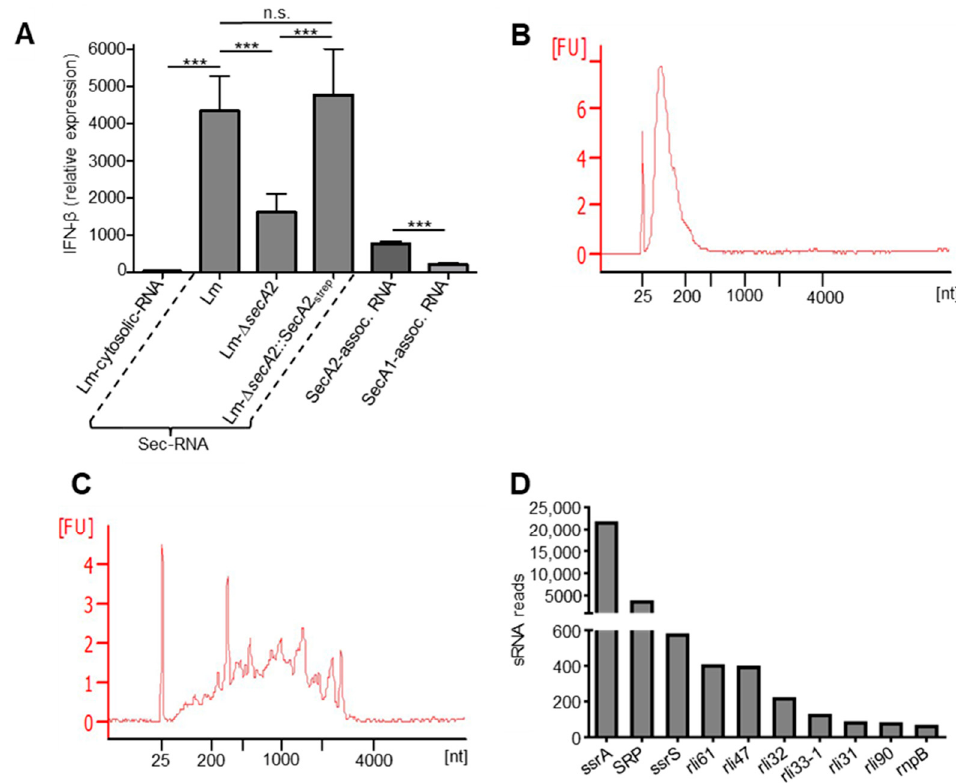
Figure 6. ( A ) IFN- β induction by cytosolic RNA, secreted RNA from wild type cultures (Lm-sec-RNA), SecA2 deletion mutant (Lm- ∆ secA2 ), the complemented strain (Lm- ∆ secA2 ::SecA2 strep ) and SecA2- and SecA1-associated RNAs. Transfection of SecA2-associated RNAs (SecA2-assoc. RNA) in bone marrow-derived macrophages (BMDM) showed higher IFN- β induction capability as compared to SecA1-associated RNAs (SecA1-assoc. RNA). The highest IFN- β induction was shown by transfection of Lm-sec-RNA isolated from the supernatant of wild type Lm cultures. Cytosolic RNA (Lm-cytosolic-RNA) was the weakest in terms of IFN- β induction. The data represent the mean ± SD of three independent experiments (n.s., nonsignificant; *** p < 0.001); ( B , C ) bioanalyzer electropherograms (RNA 6000 Nano Chip) showing profiles of RNAs associated to purified SecA2 ( B ) and SecA1 ( C ). The results represent one of three independent experiments; and ( D ) SecA2-associated small non-coding RNAs (sRNAs) arranged according to their transcript numbers (top ten). Data represent means of two independent experiments.